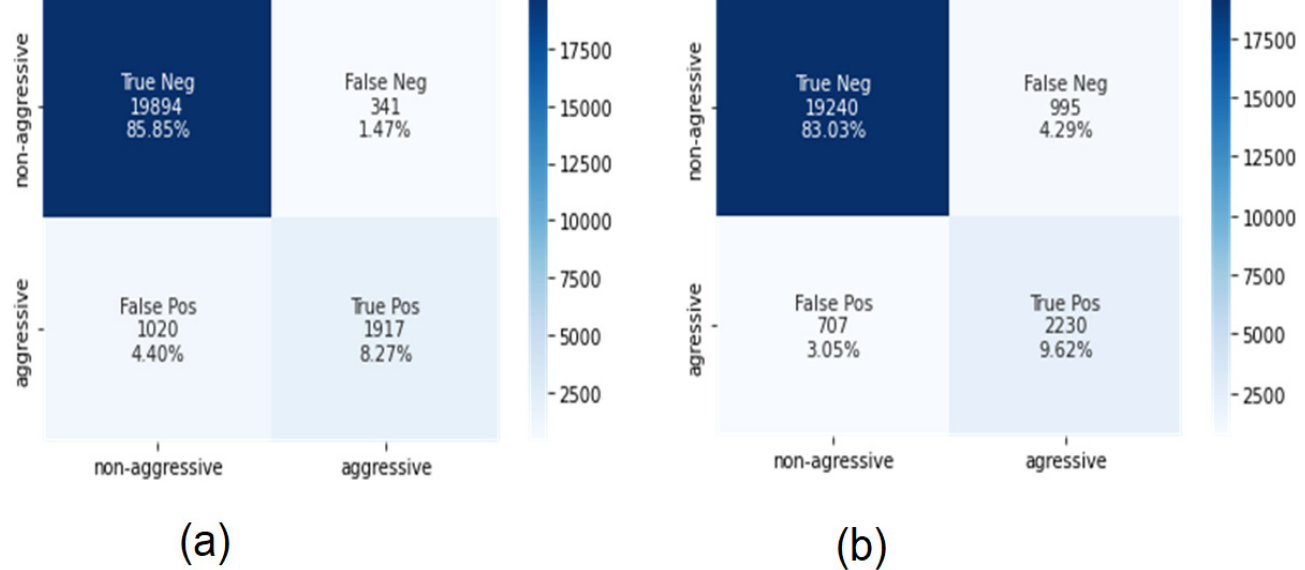
Figure 5. Confusion matrices of the BiLSTM ( a ) and CNN-BiLSTM ( b ) using the binary dataset.